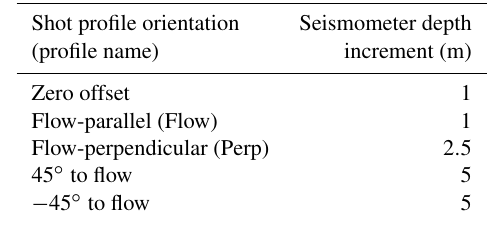
Figure 2. Seismic phase velocities for a single crystal dependent on angle θ to the c axis, calculated with values for the elastic con- stants from adiabatic single-crystal artificial water ice at − 16 ◦ C from Gammon et al. (1983) using the MTEX toolbox (Mainprice et al., 2011). (a) P-wave velocity v P . (b) S-wave velocities v S . Table 1. Multi-azimuth VSP survey